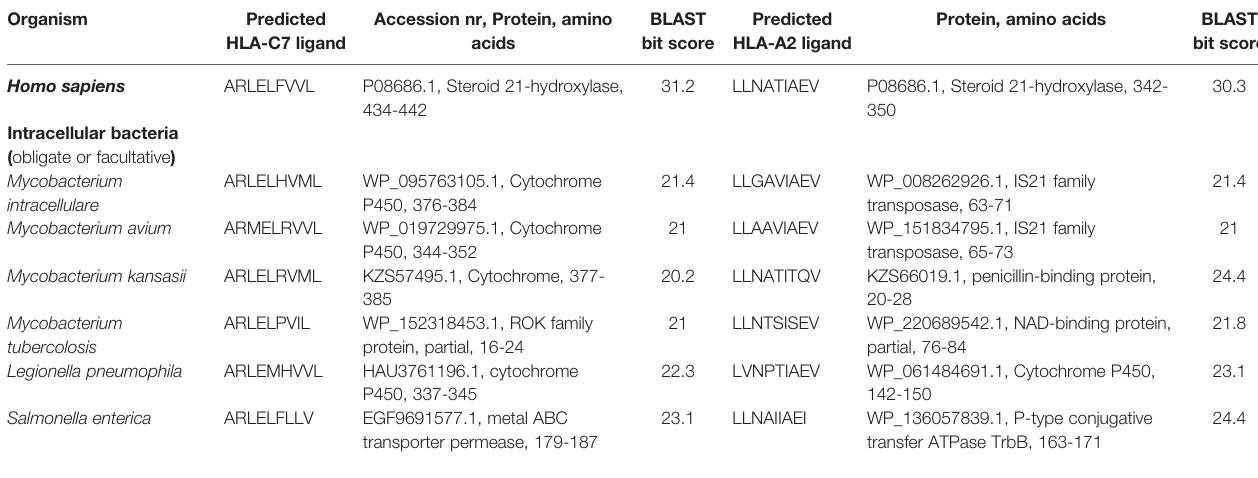
TABLE 1 | Peptides derived from intracellular bacteria reported to colonize humans with closest sequence homology to the CD8+ T cell restricted epitopes of 21OH.